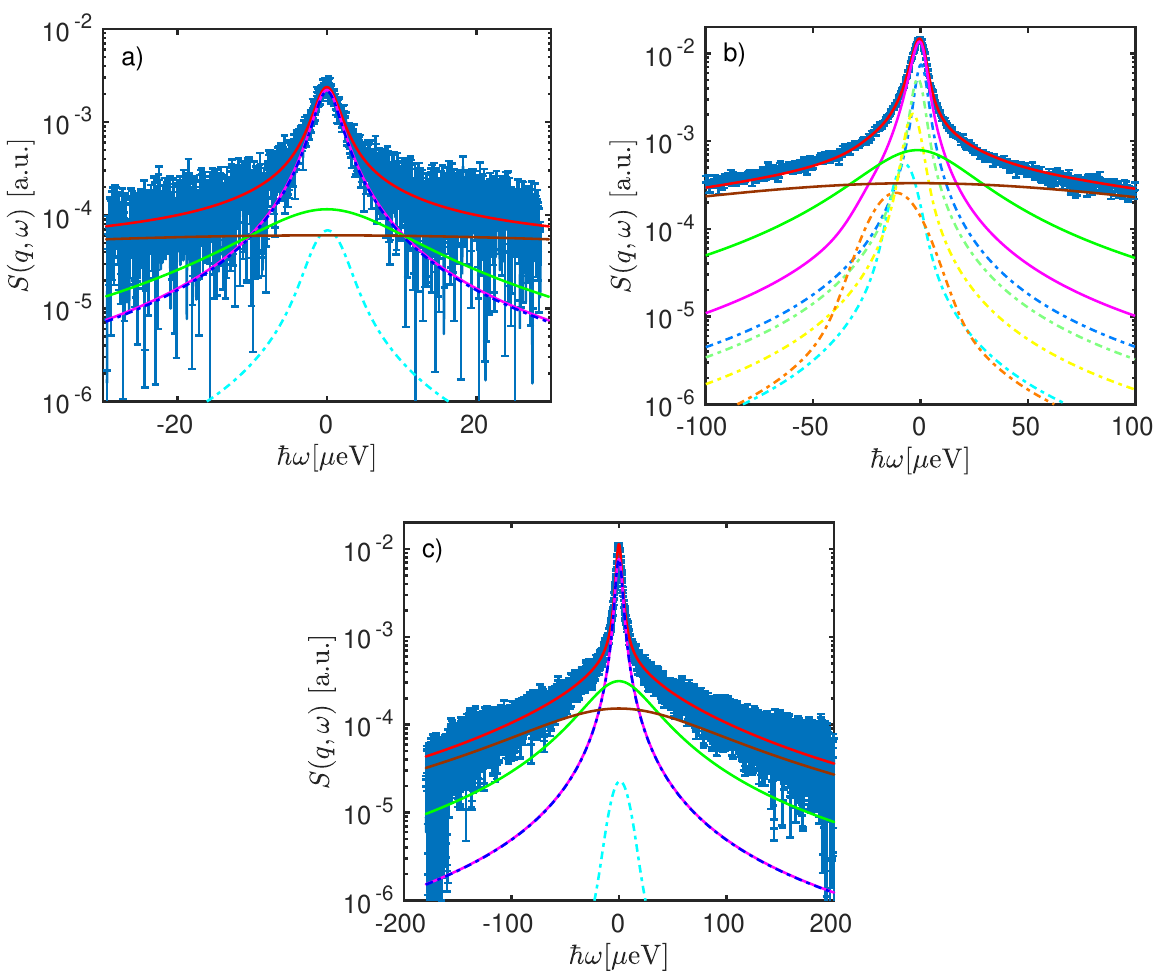
Figure 2: Spectra from aqueous (D 2 O) BSA protein solutions recorded on different spectrometers (symbols) and associated fits (solid red lines superimposed on the symbols). The individual Voigt components associated with the convoluted apparent center-of-mass diffusion (magenta line) corresponding to each Gaussian in the resolution model are displayed as dash-dotted lines, with the colors corresponding to the ones used in Figure 1. In addition, the rescaled water contribution and the internal diffusion contribution are depicted as solid brown and green lines, respectively, without displaying their individual Voigt components. The protein concentrations in the samples as well as the sample temperatures differ for the spectra displayed: a) IN16b: c p = 100 mg/ml; T = 280 K; q = 1 . 0 Å − 1 ; b) BASIS: c p = 200 mg/ml; T = 295